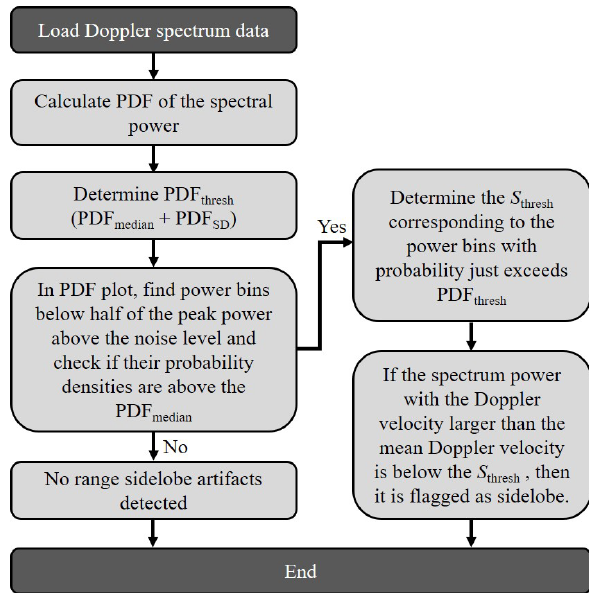
Figure 7. Flowchart of range sidelobe artifact processing.